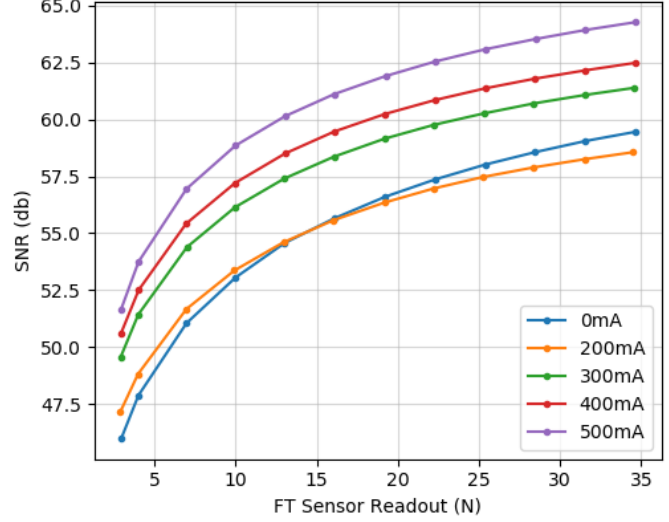
Figure 13. Signal-to-noise ratio (SNR) curves. Ratios change depending on the force applied. Normal force experiment readouts at five different currents on the